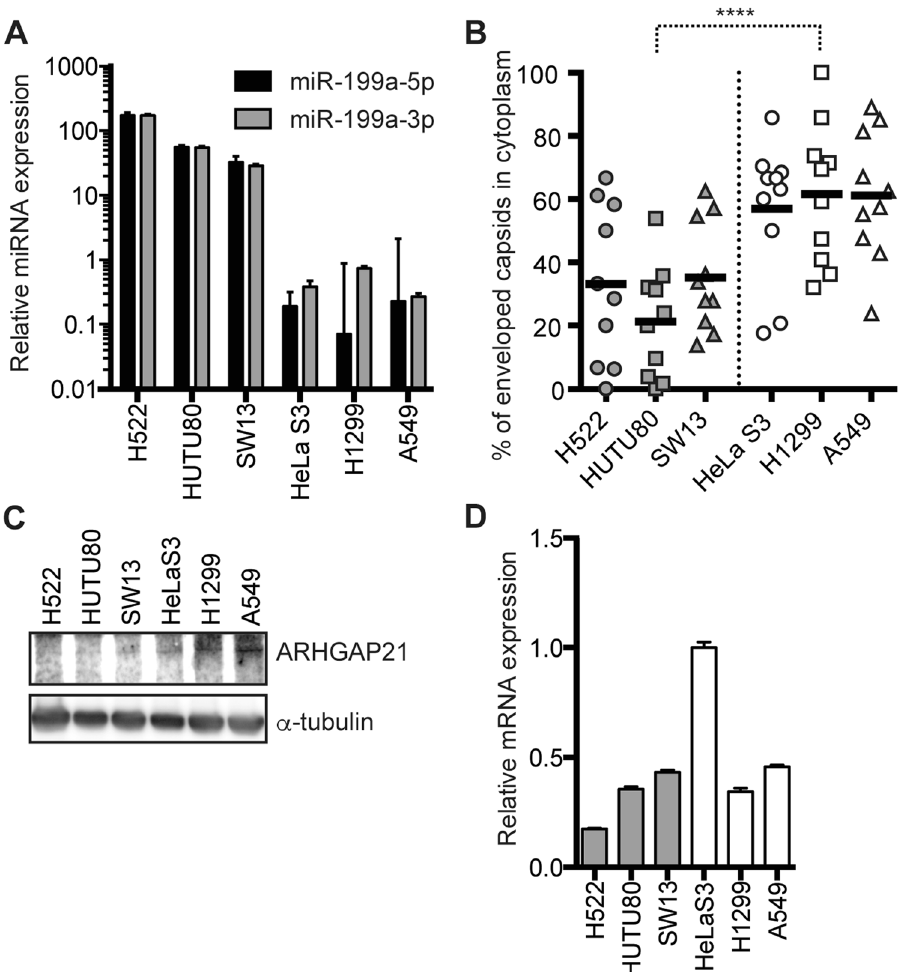
Figure 5. Endogenous expression levels of miR-199a-5p and -3p negatively correlate with secondary envelopment efficiency. ( A and D ) qRT-PCR analysis of miR-199a-5p and miR-199a-3p ( A ) and ARHGAP21 mRNA ( D ) in human epithelial cancer cell lines. RNUB6 and GAPDH were used as an internal control for miRNA and mRNA quantification, respectively. ( B ) Percentages of enveloped capsids in the cytoplasm versus total capsids, calculated by counting capsids in TEM images of HSV-1-infected (moi of 5/20 hpi) human epithelial cancer cell lines. ( C ) Western blot analysis of ARHGAP21 and α -tubulin in human epithelial cancer cell lines. In ( A and D ), the data represent the means ± s.d. ( n = 3). In B, the bars represent the medians and the asterisk indicates the p value (Mann-Whitney U -test). **** p < 0.001.